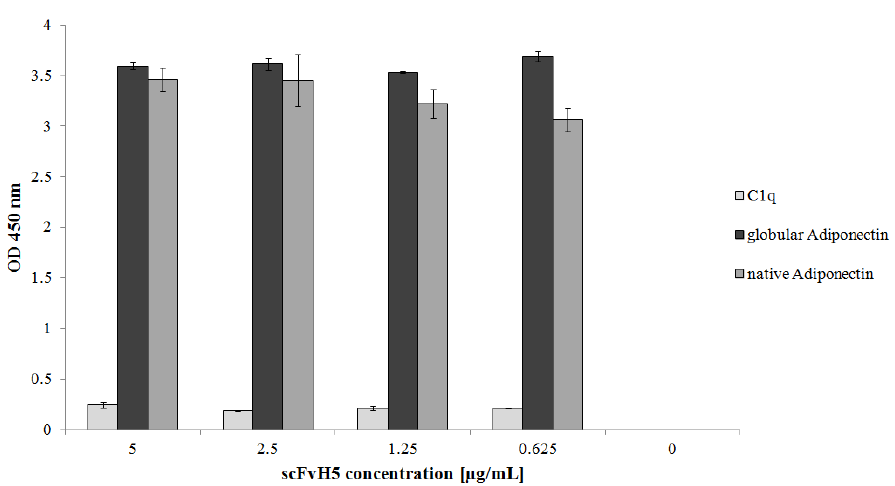
Figure 7. The purified scFvH5 can bind to globular and native adiponectin. In an ELISA, 100 µL of recombinant globular or native adiponectin (Biovendor) or C1q as negative control (1 µg/mL each) were coated on a microtiter plate and different concentrations of scFvH5 were used for antigen. The ELISA results are given as mean ± SD values from triple determinations.